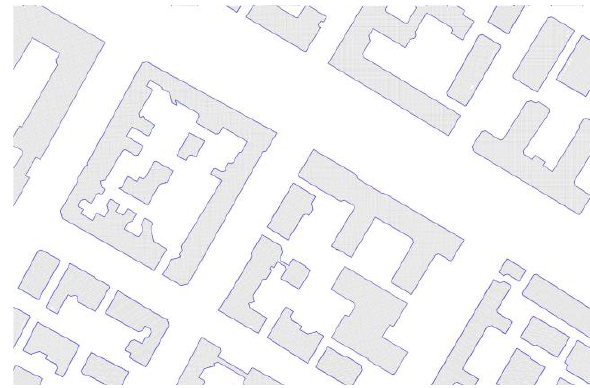
Figure 9. Reconstructed building outlines.